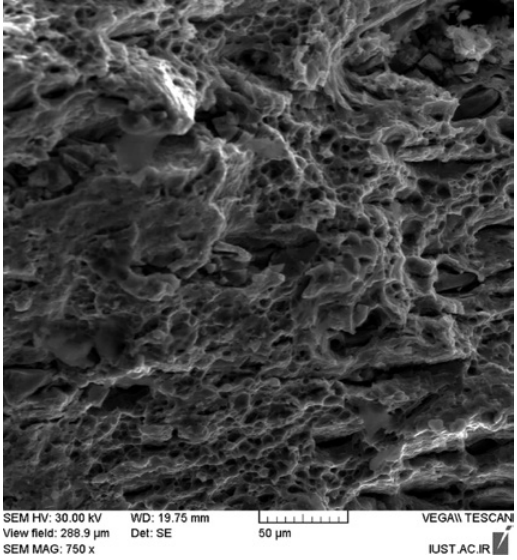
Figure 5: SEM micrograph of the fracture surface of AA8090/6% SiC composite at peak aged after directional p